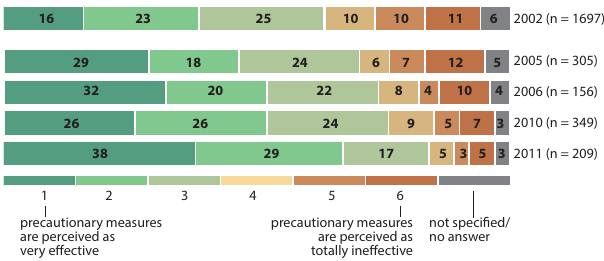
Figure 3. Perceived effectiveness of private precautionary mea-